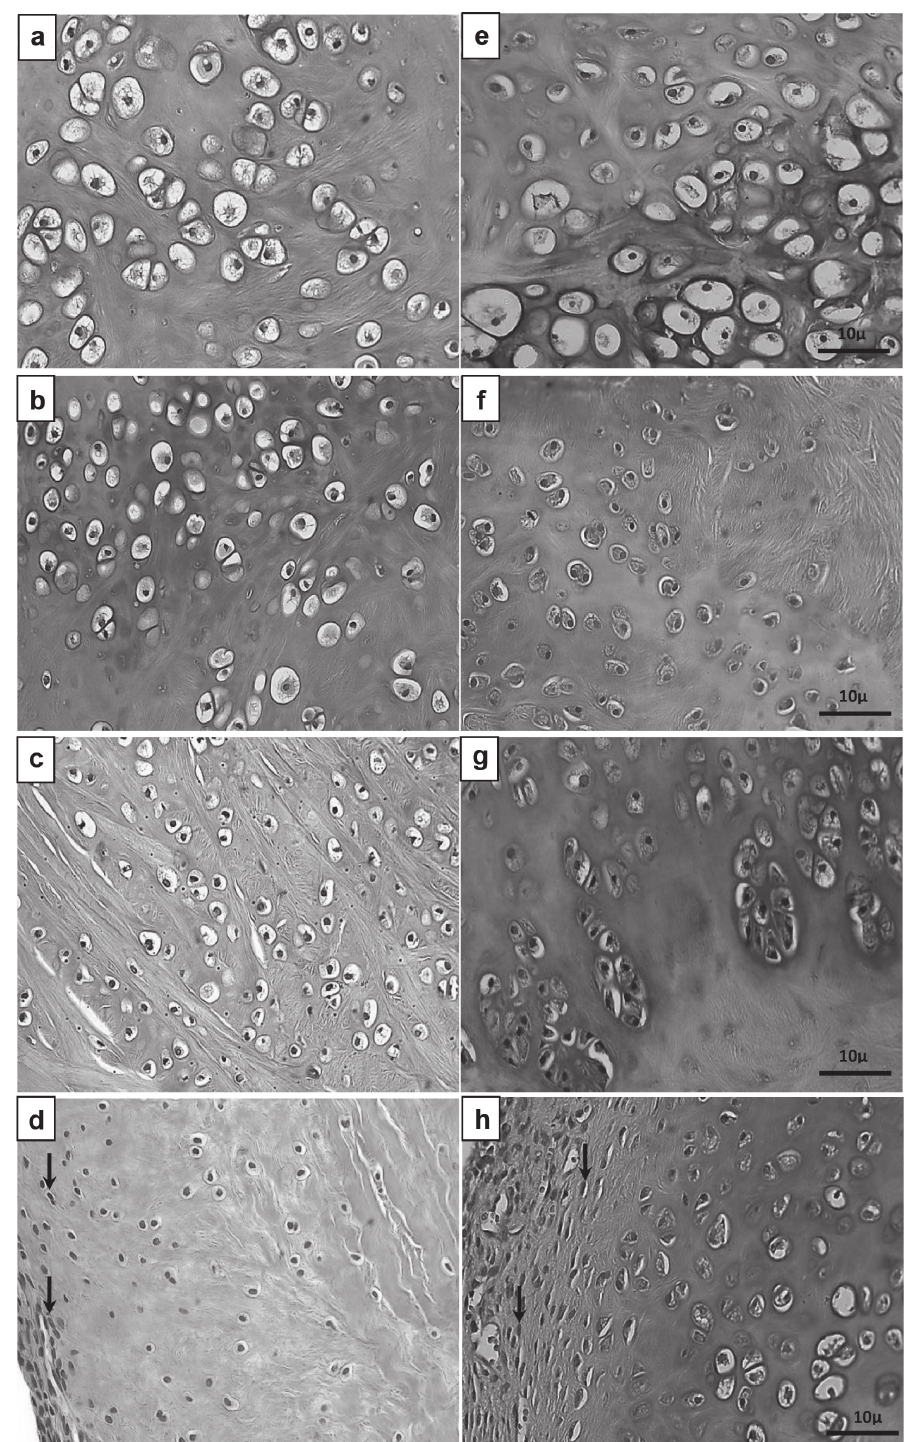
Figure 3 - Photomicrographs of the horns from the contralateral ( a , b , c and d ) and treated menisci ( e , f , g and h ), showing chondrocytes involved by intersticial substance. In figures d and h , fibroblast and fibrocytes (arrows) are observed in the peripheral regions of the horns and chondrocytes in the central region. HE. (See the colors in the online